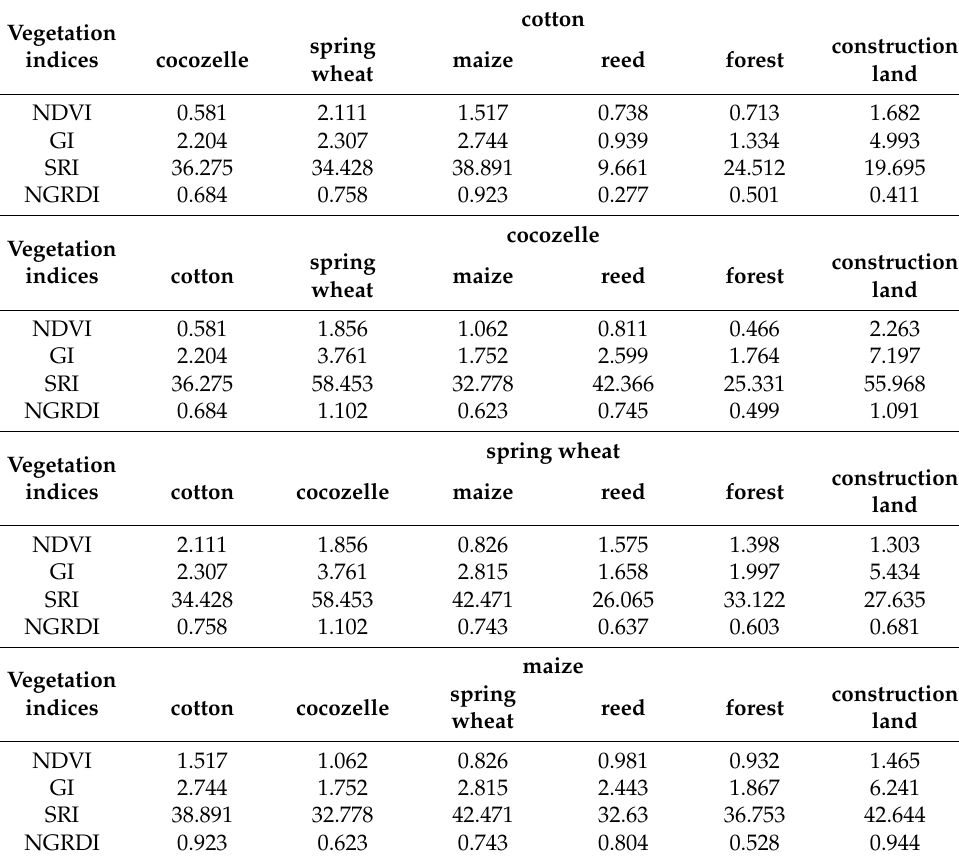
Table 2. Euclidean distance between different crop types under different vegetation